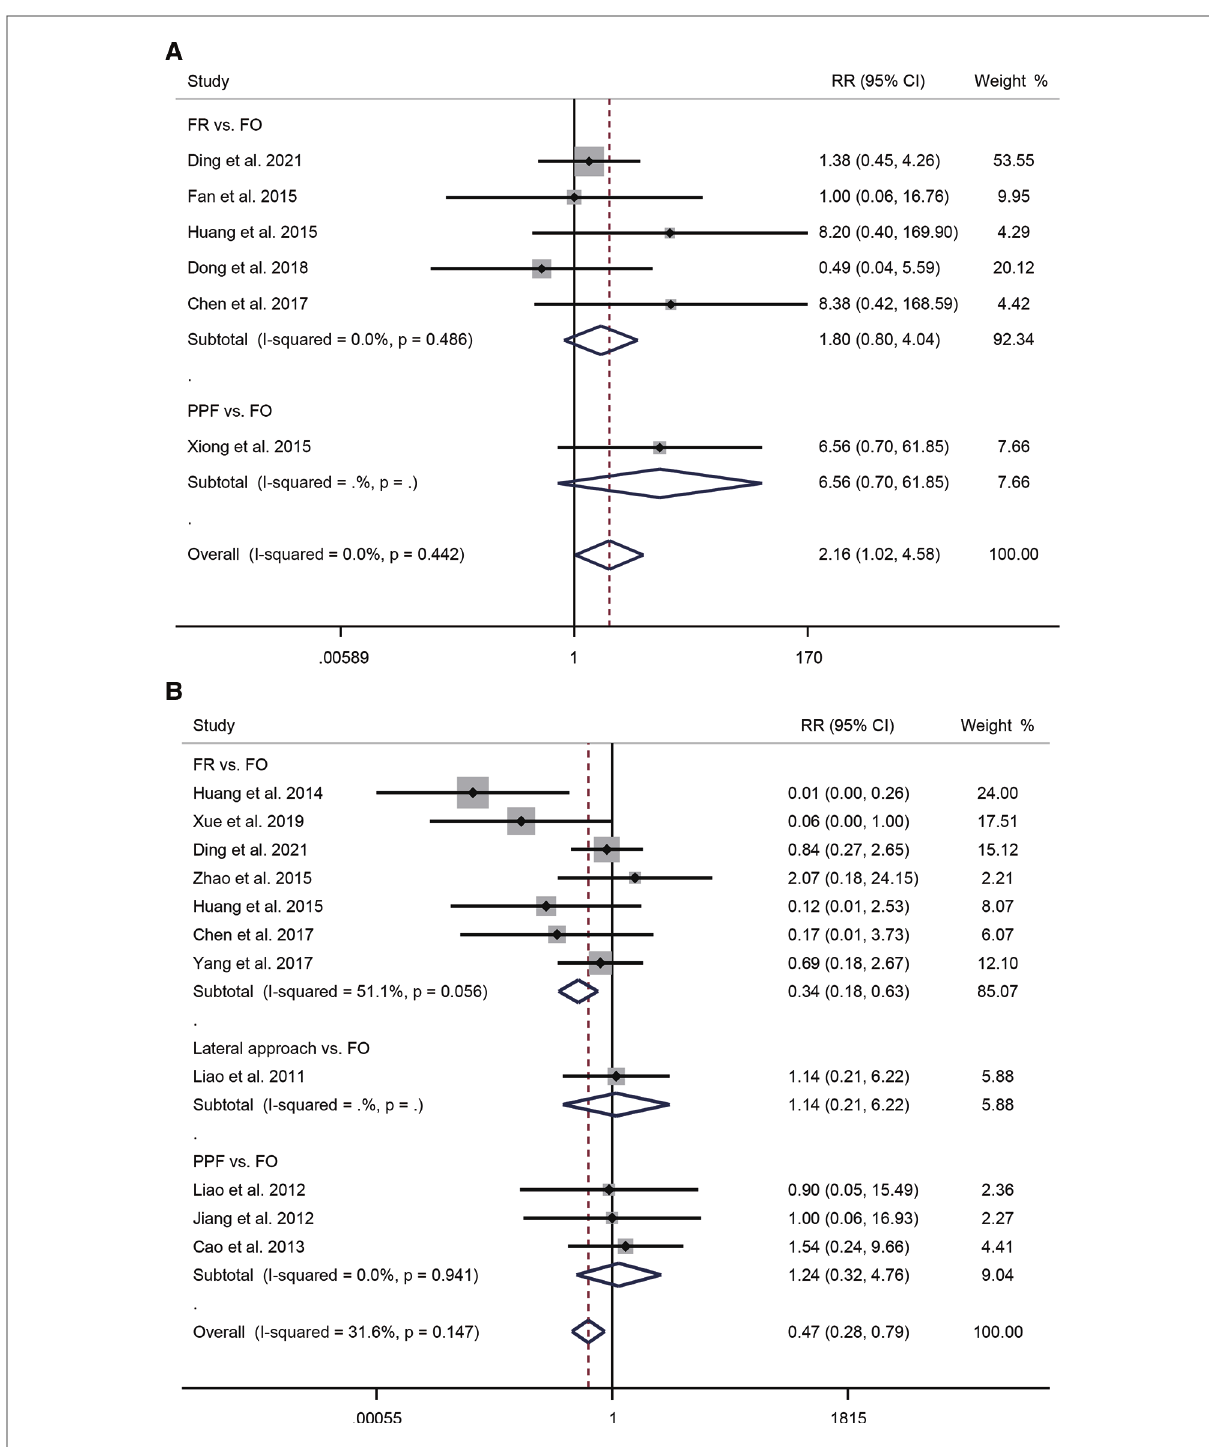
FIGURE 3 Forest plot of ef fi cacy ( A ) and recurrence rate ( B ) for the comparison of different puncture approaches (other puncture approaches vs. FO). FO, foramen